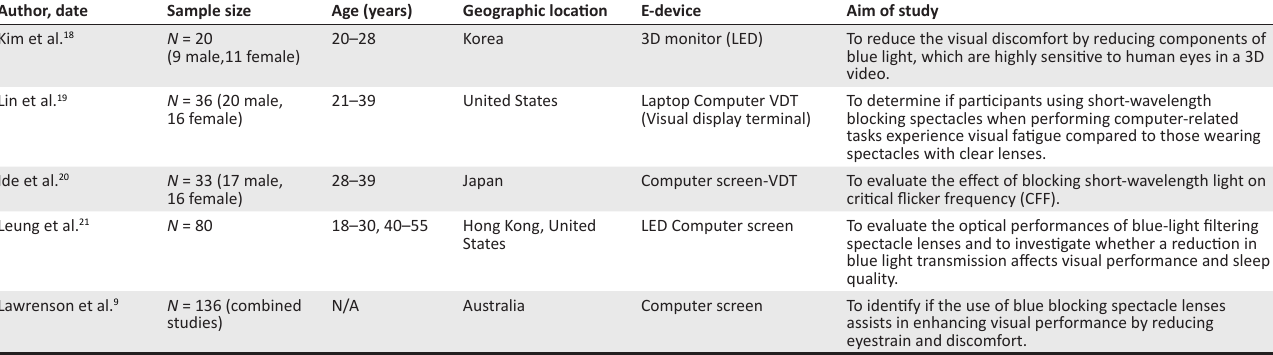
LED Computer screen To evaluate the optical performances of blue-light filtering spectacle lenses and to investigate whether a reduction in blue light transmission affects visual performance and sleep quality. Computer screen eyestrain and